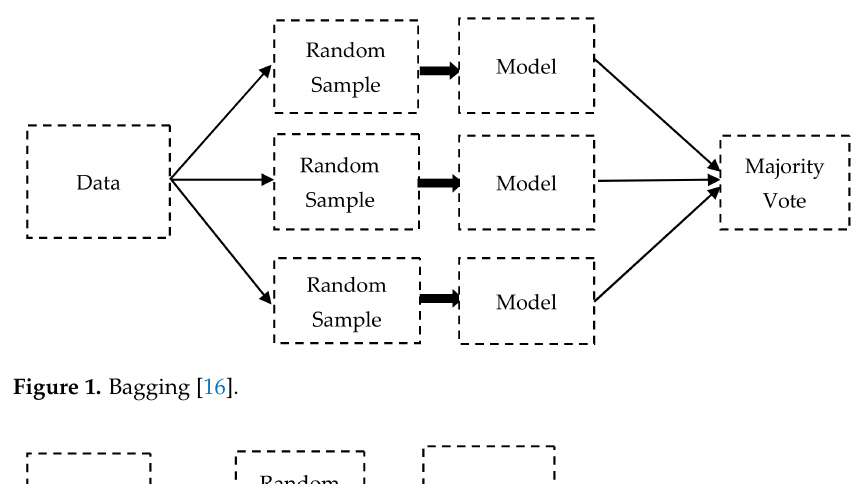
Figure 1. Bagging [16].